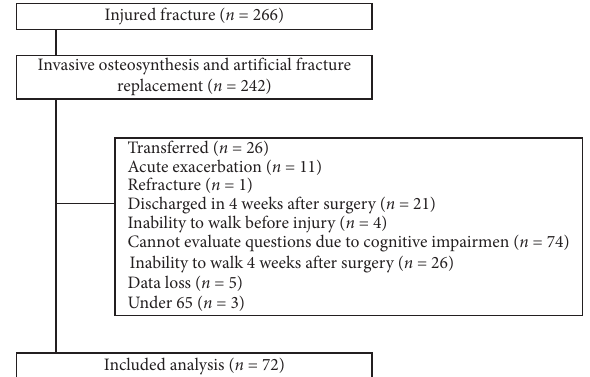
Figure 1: Flow chart outlining the number of participants in each arm of the